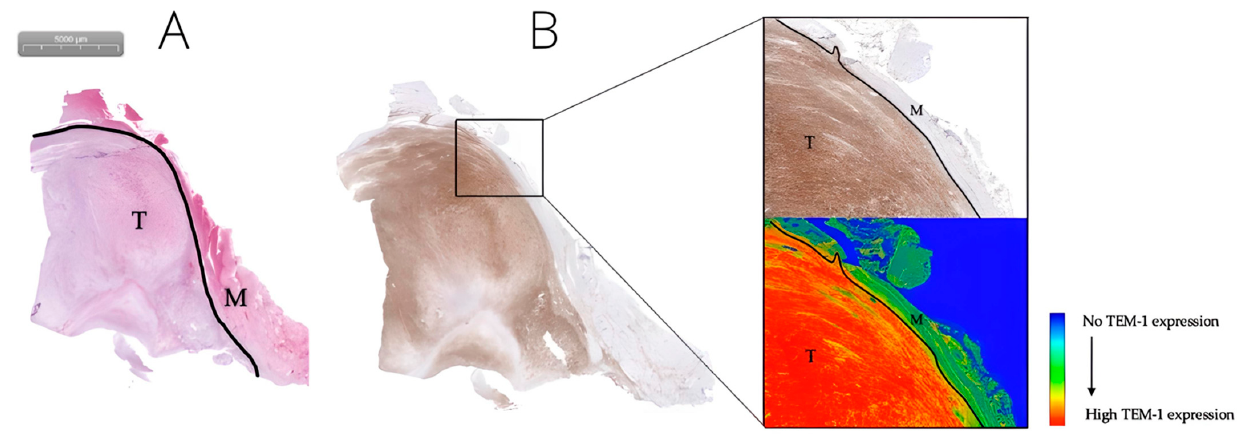
Figure 2. Grade 2 MFS located in the upper arm of a 63-year-old female. H&E staining of MFS tumor tissue (T), the tumor border (black line), and adjacent muscle tissue (M) ( A ). Corresponding TEM-1 staining ( B ): the upper right 10× enlarged image displays tumor tissue (T), the tumor border (black line), and adjacent healthy muscle tissue (M). The lower-right corresponding image shows a gradient map of the same TEM-1 staining, which clearly delineates tumor from adjacent healthy tissue.